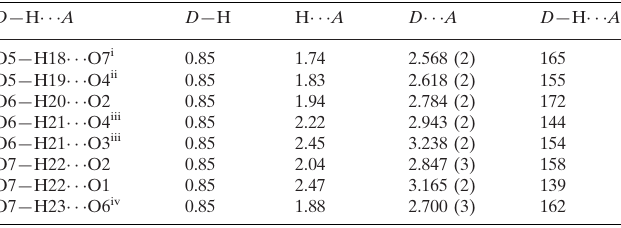
Hydrogen-bond geometry (A˚ , (cid:5)